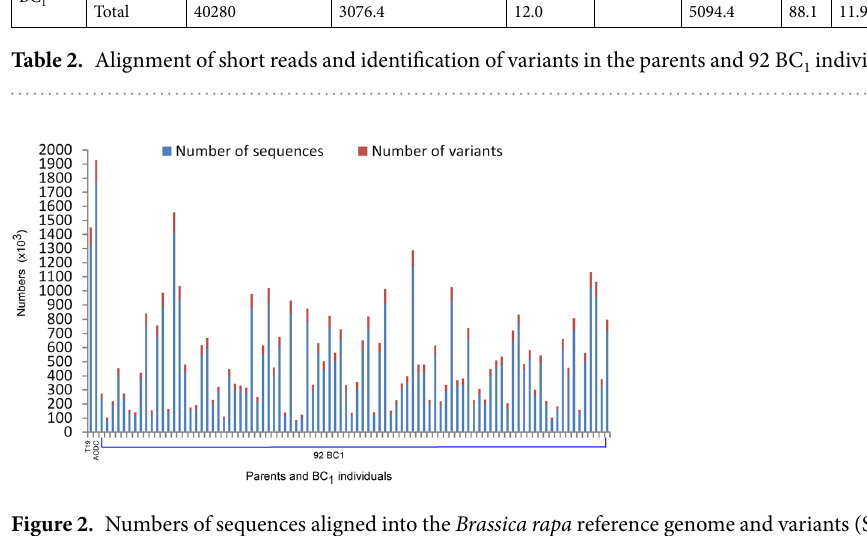
Figure 2. Numbers of sequences aligned into the Brassica rapa reference genome and variants (SNPs and InDels) identified in each sample in comparing with the DNA sequence of the reference